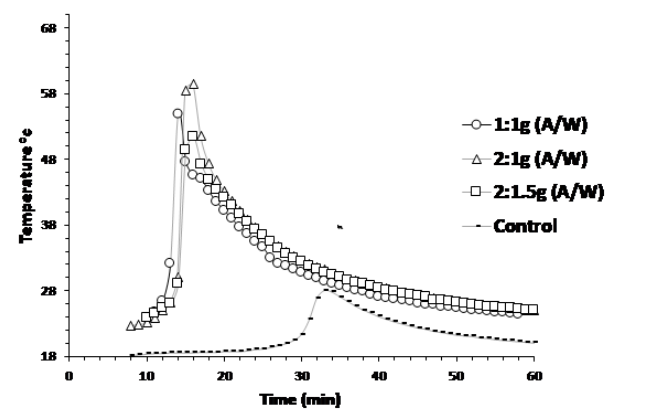
start of mixing